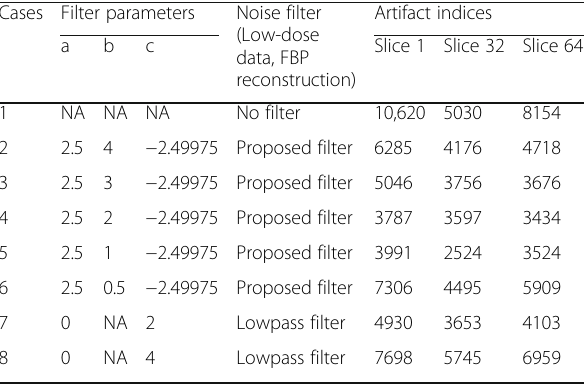
Table 1 Artifact index study for some reconstructed images Cases Filter parameters Noise filter